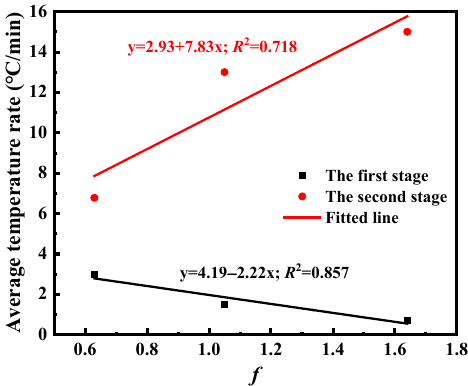
Figure 24. Relationship between average temperature rising rate and f value.